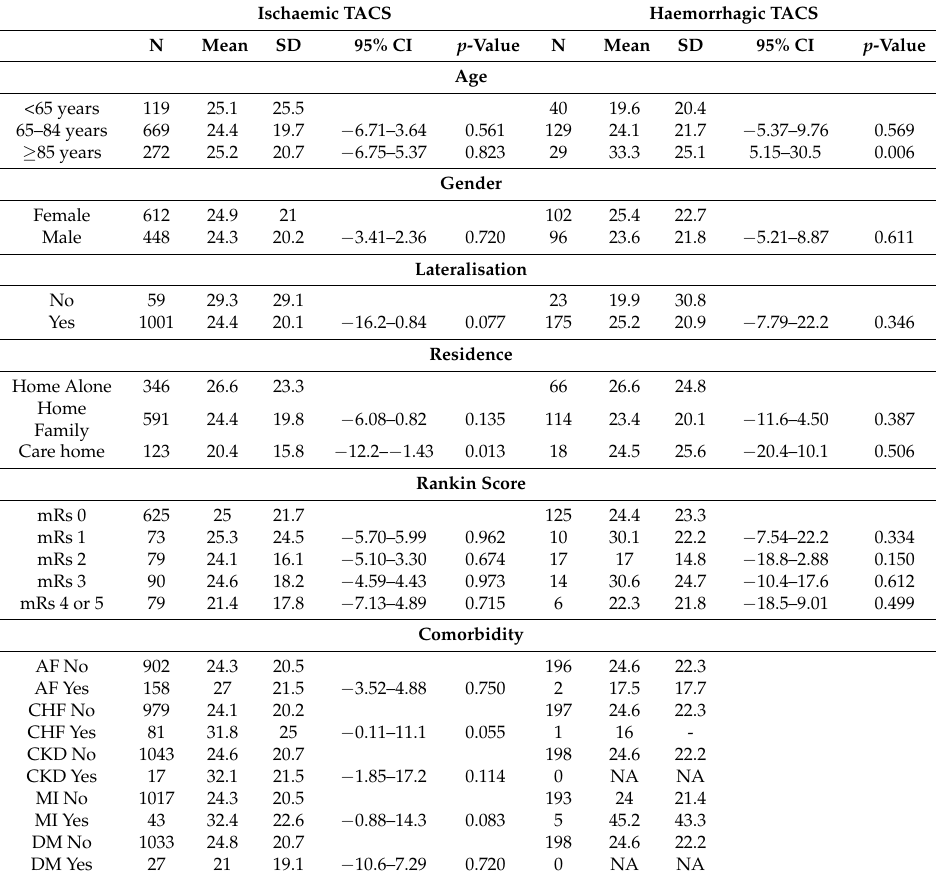
Table 3. Adjusted length of stay analysis with 95% confidence intervals of ischaemic and haemorrhagic TACS in patients who were alive at